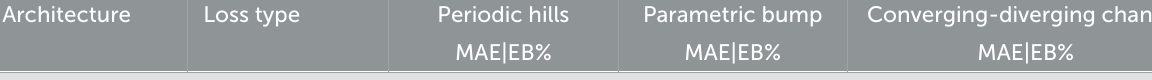
TABLE 2 The mean absolute errors (MAEs) and error bound (EB) percentages for the extrapolative test cases of different geometric flow fields from the mean flow example, using every combination of model architecture and loss function type.